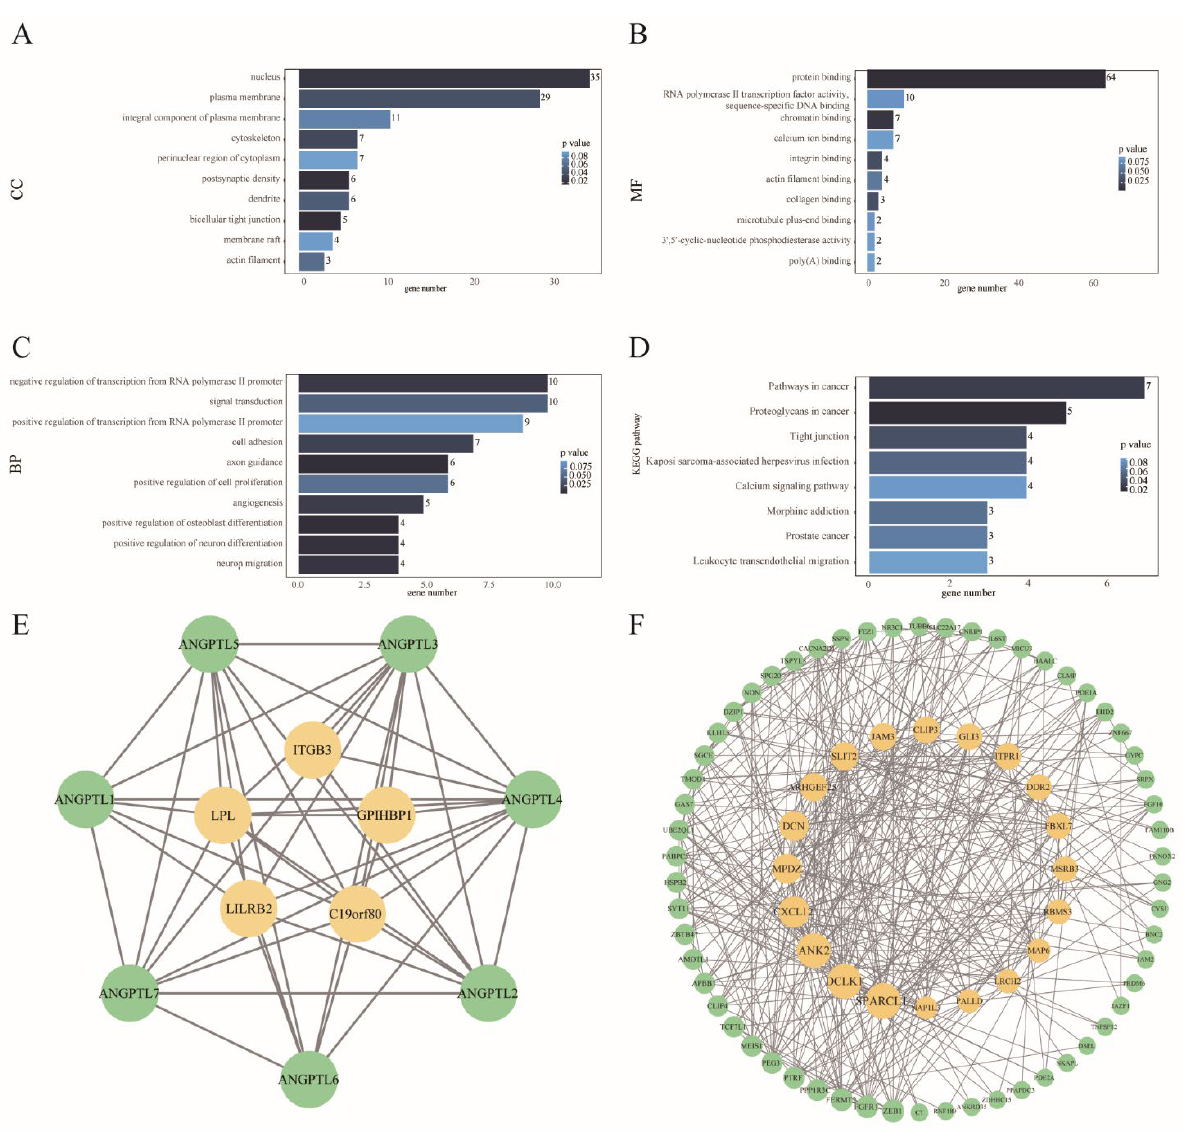
Figure 5. The function and interaction analyses of ANGPTLs in CRC patients (DAVID). ( A – D ) GO enrichment and KEGG pathway analysis of 100 co-expressed genes in ANGPTLs. ( A ) CC—cellular component. ( B ) MF—molecular function. ( C ). BP—biological process. ( D ) KEGG—Kyoto encyclopedia of genes and genomes. ( E ) Protein–protein interaction (PPI) enrichment analysis of seven ANGPTLs. ( F ) PPI enrichment analysis of 100 genes co-expressed with